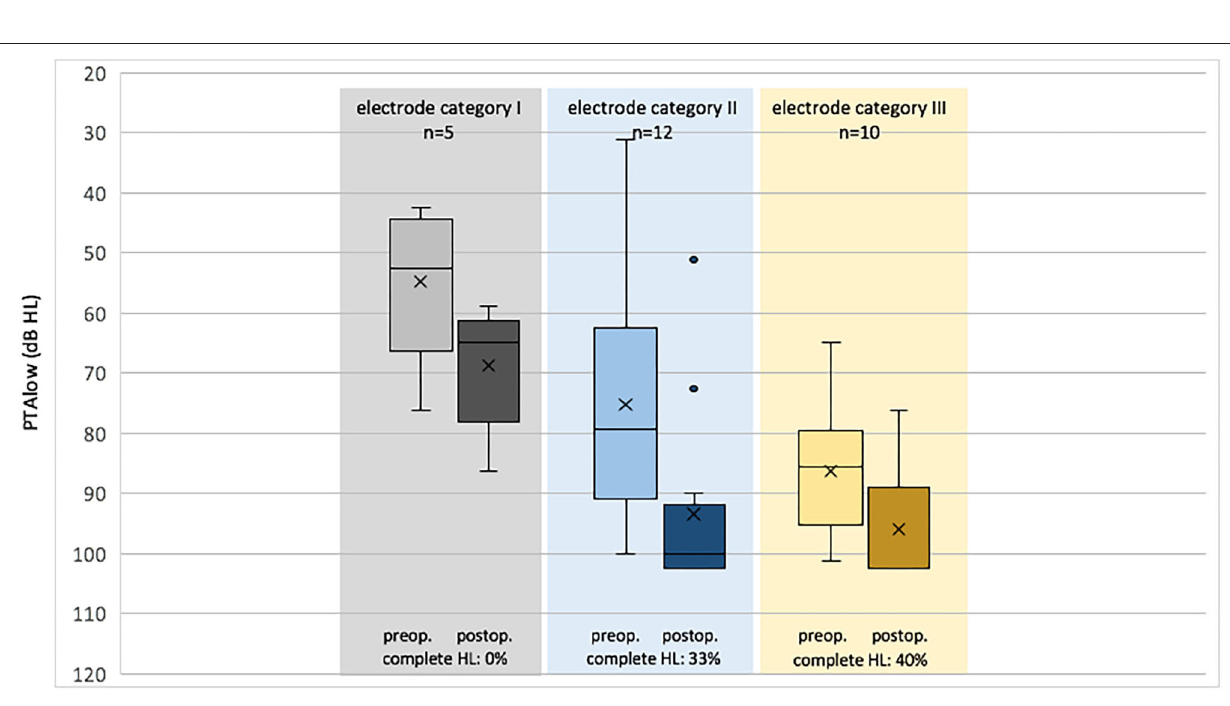
Frontiers in Neurology |